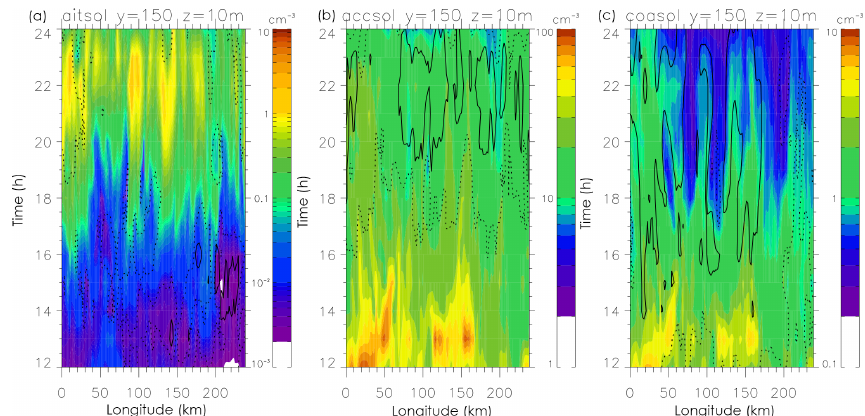
Figure 5. Temporal evolution of the aerosol concentration from the Aitken (a) , accumulation (b) , and coarse (c) soluble mode after the model spin-up. Temporal evolution of the aerosol dry radius is also illustrated for the three modes: 30 (dashed line) and 35nm (solid line) for the Aitken soluble mode, 110 (solid line) and 115nm (dashed line) for the accumulation soluble mode, and 0.96 (solid line) and 1.0µm (dashed lines) for coarse soluble mode. Note that the colour scales are different.